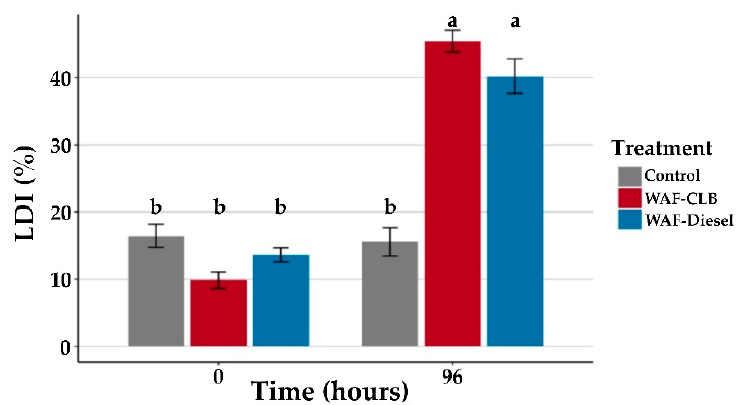
Figure 5. Fraction of lysosomal membrane destabilization (LDI) in lobster’ hemocyte cells for each Table 2 0 h of exposure. Series A and B are combined; Mean ± SE; n = 6. The letter symbols indicate a significant (p < 0.05) effect between time and treatment.